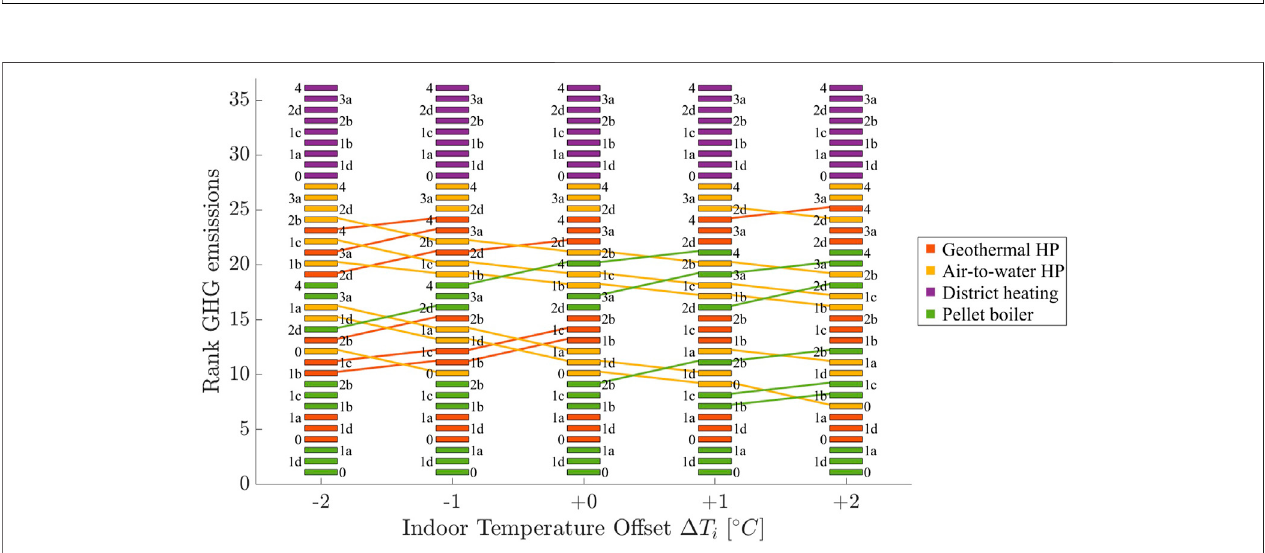
FIGURE6| Measurementuncertaintyimpactontherankofpredictedperformanceofretro fi tmeasures.Thechangesisranksaresmallwithoneortwopositionsat maximum.